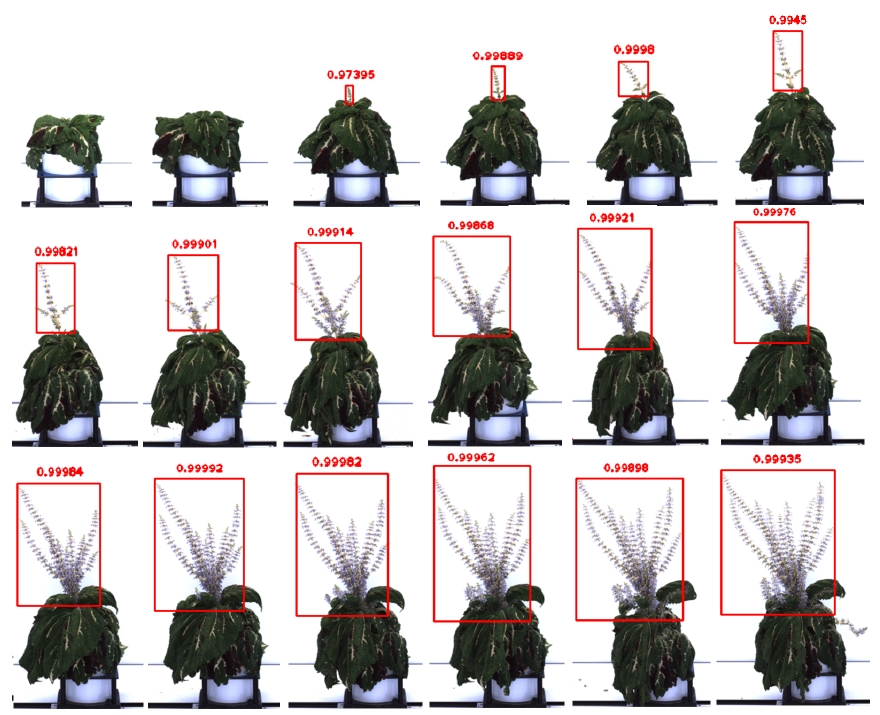
Figure 14. Illustration of flower emergence timing detection and its growth over consecutive days (following left to right direction) using a sample Coleus image sequence (D2) for the side view 0 ◦ starting from Day 16 ( top-left ) to Day 33 ( bottom-right ).